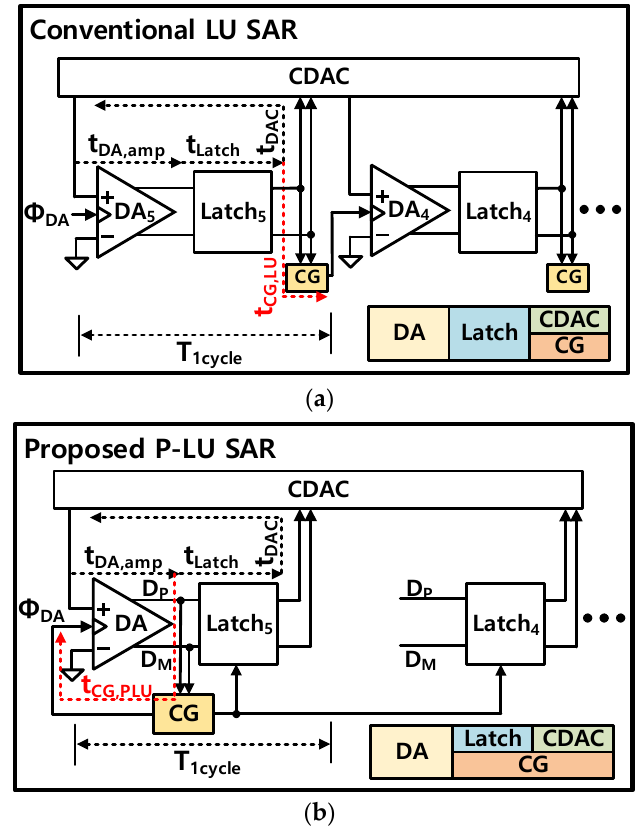
Figure 3. Comparison of the main clock paths of ( a ) the LU SAR ADC and ( b ) the proposed P-LU SAR ADC. Table 1. Comparison for SAR ADC